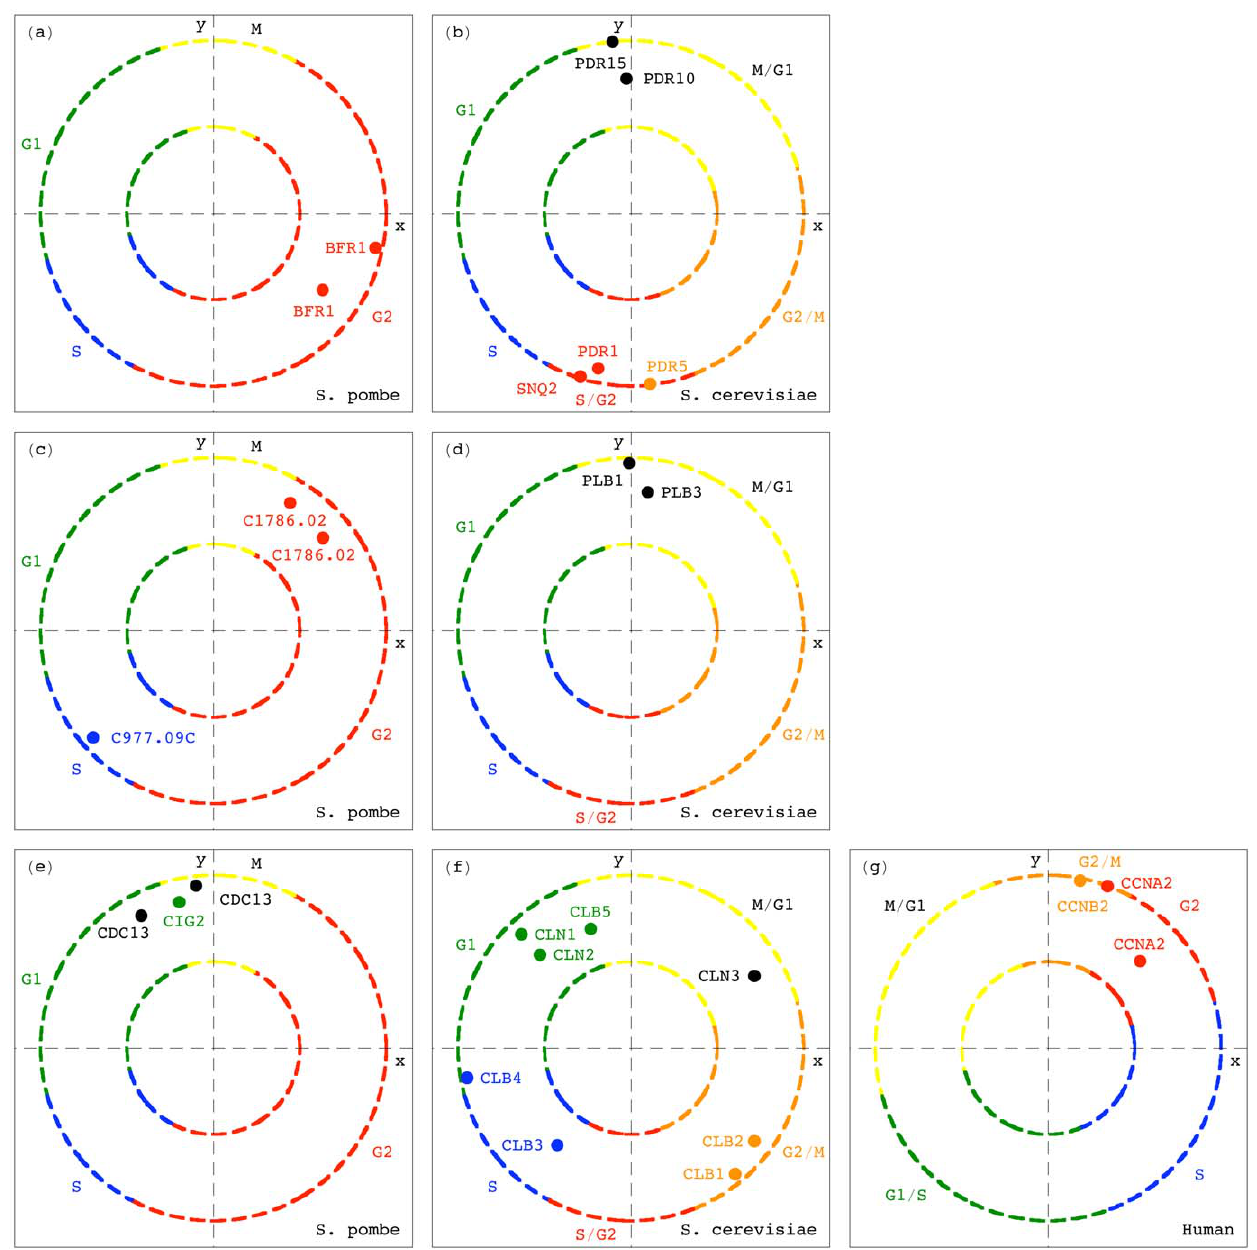
Figure 4. Simultaneous HO GSVD classification of homologous genes of different cell-cycle peak times. ( a ) The S. pombe gene BFR1 , and ( b ) its closest S. cerevisiae homologs. ( c ) The S. pombe and ( d ) S. cerevisiae closest homologs of the S. cerevisiae gene PLB1 . ( e ) The S. pombe cyclin- encoding gene CIG2 and its closest S. pombe , ( f ) S. cerevisiae and ( g ) human homologs.